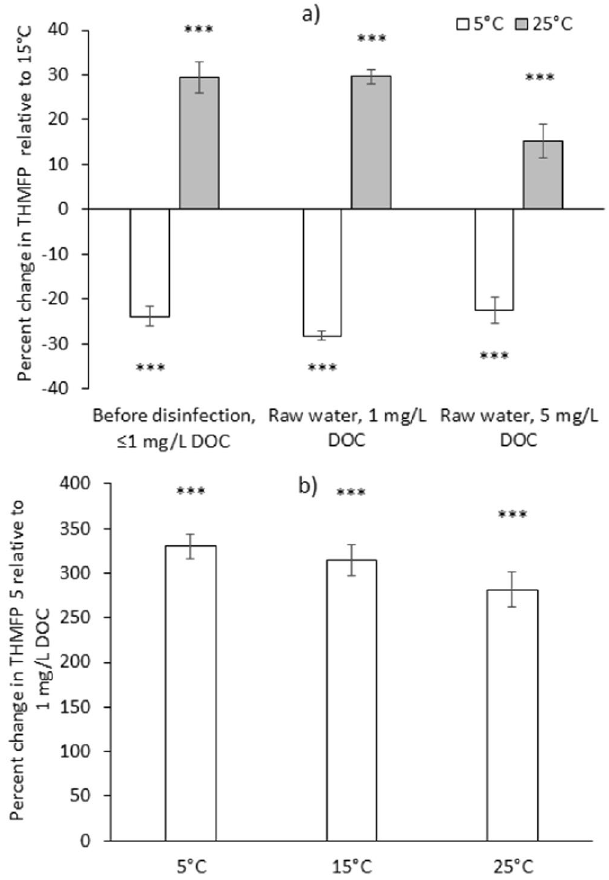
Figure 3. ( a ) Temperature and ( b ) DOC concentration effect on the trihalomethanes formation potential (THMFP) in laboratory experiments for water sampled from the five case study sites. Error bars indicate the standard errors (n = 20) between the measurements for waters from different sites and seasons, while stars indicate the significance of the z-test results for the observed change being different from zero ( *** p ≤